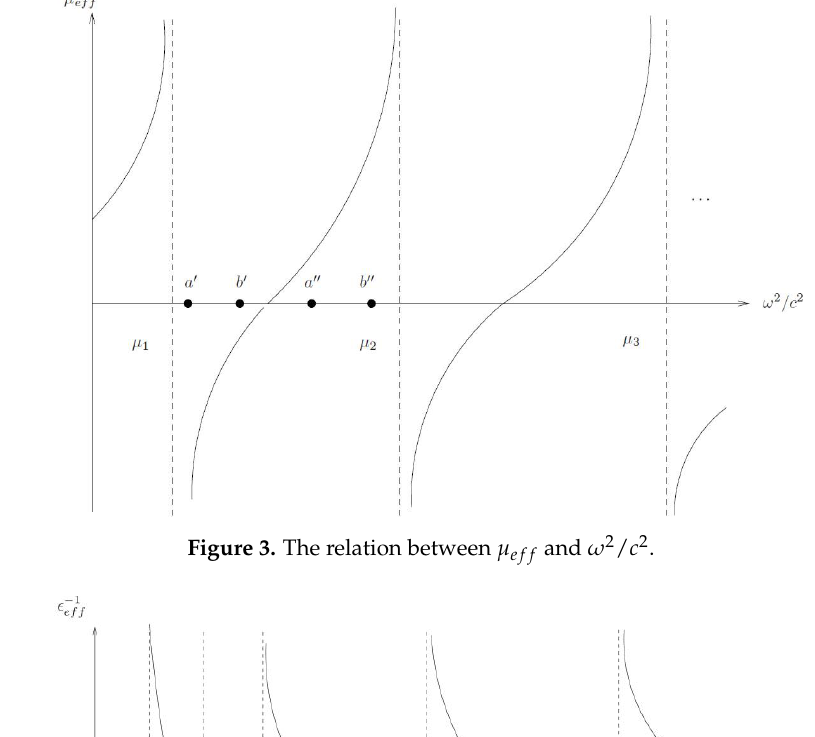
Figure 3. The relation between µ ef f and ω 2 / c 2 .